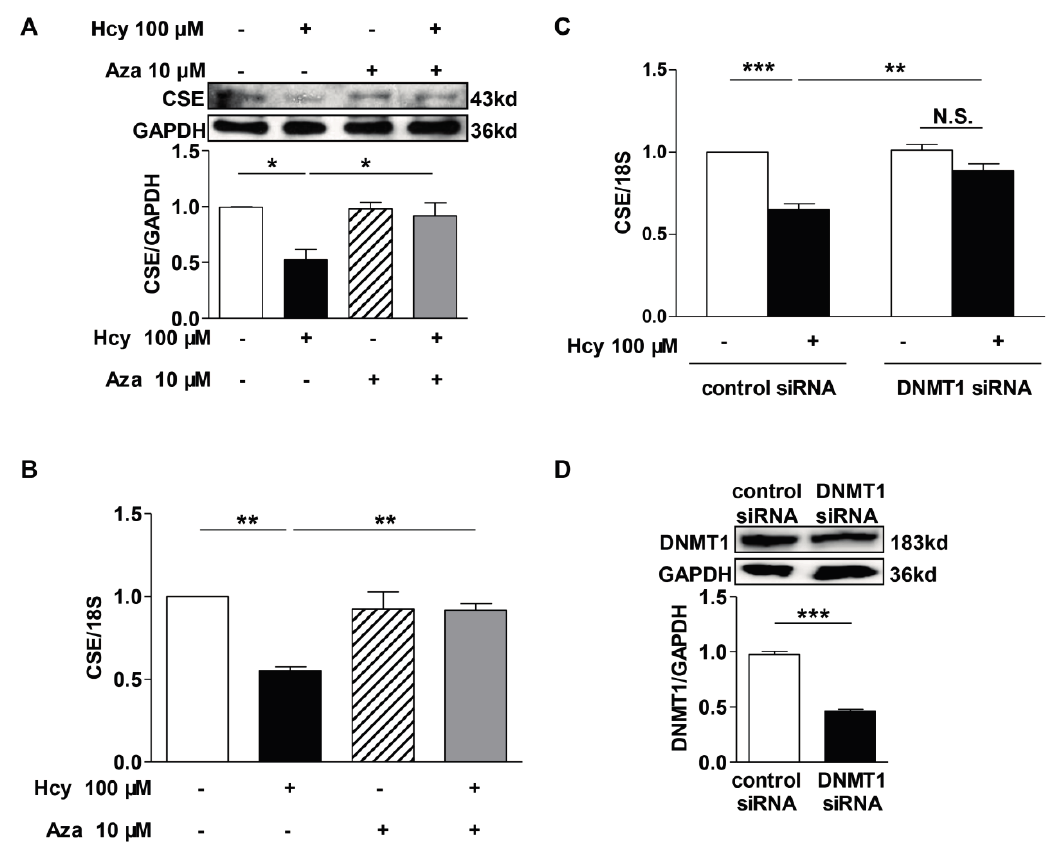
** p < 0.01, *** p < 0.001. N.S., not